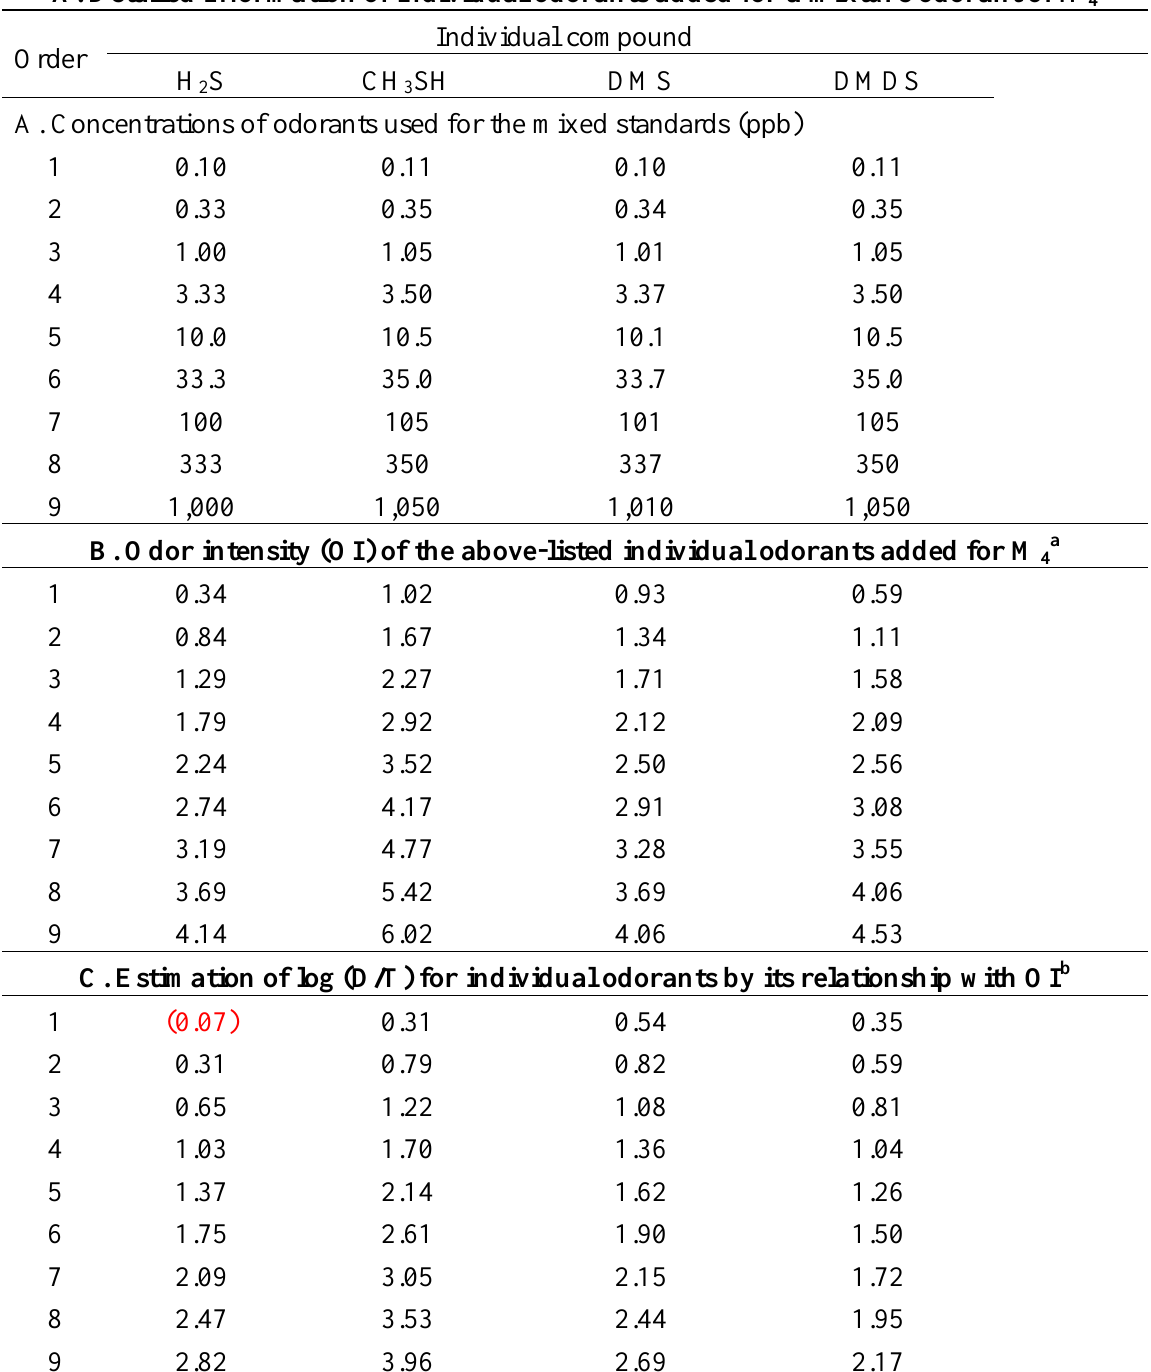
between odor intensity and dilution-to-threshold (D/T)